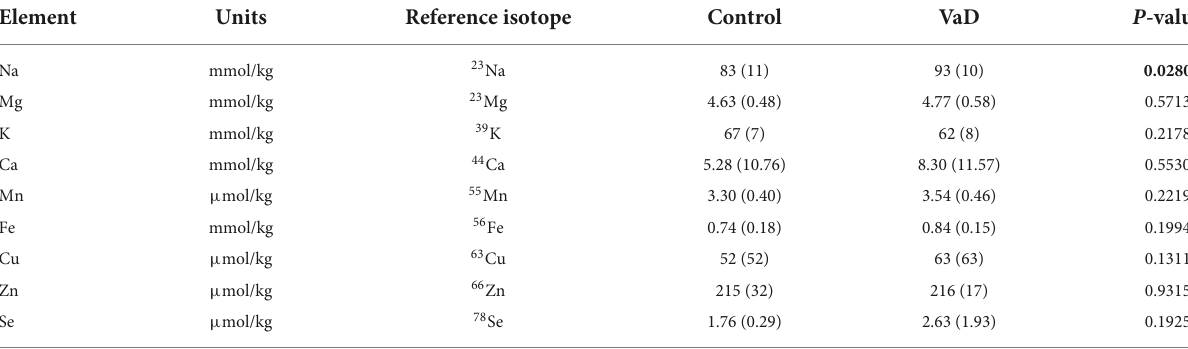
TABLE 4 Wet-weight metal concentrations in the middle temporal gyrus of VaD and control brains. Element